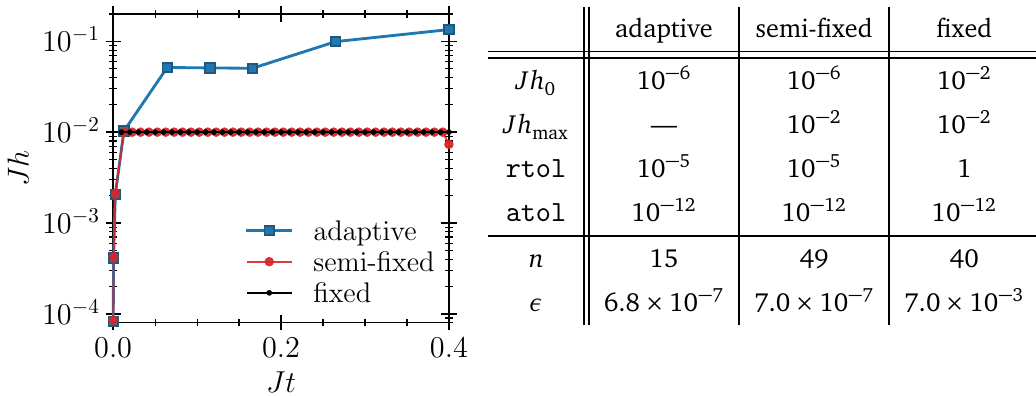
= 9. The black max ( h k max + 1 ) . O